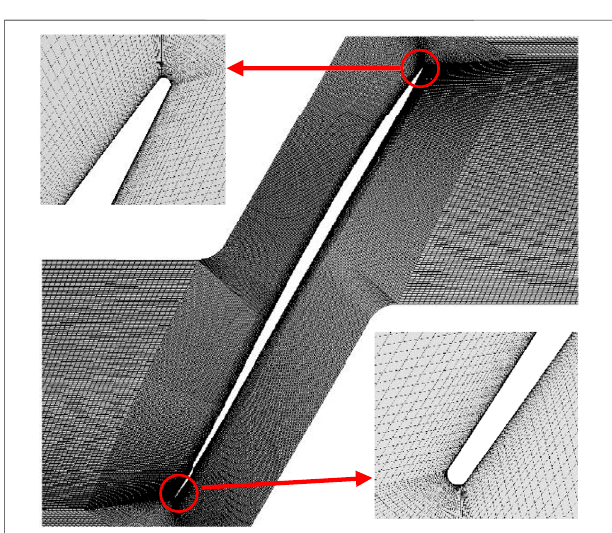
FIGURE 2 | Grid of the cascade.